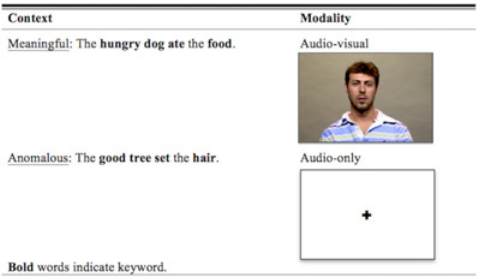
Fig 1. Schematic of stimuli presentation and experimental